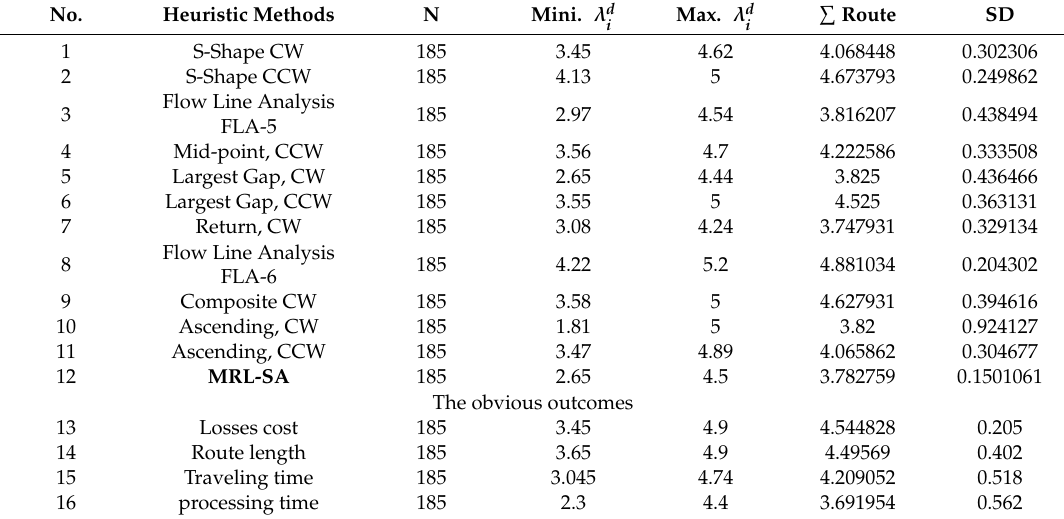
Table 3. Reviewed and Proposed heuristics implementation (statistical analysis x10 3